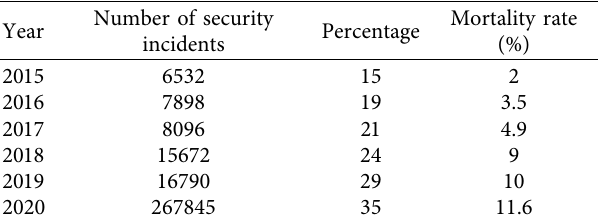
Table 3: Traffic accidents and fatalities from 2015 to 2020.